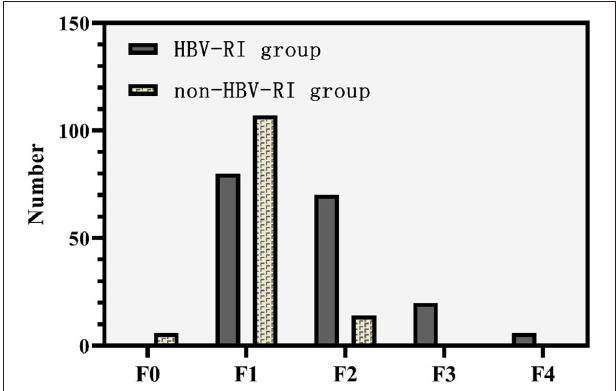
FIGURE 5 | Fibrosis stage F between the HBV-RI group and the non-HBV-RI group. HBV-RI group, HBV-related inflammation group; non-HBV-RI group, non-HBV-related inflammation group; HBV-related inflammation group: F0: 0 cases, F1: 80 cases, F2: 70 cases, F3: 20 cases, F4: 4 cases; non-HBV-related inflammation group: F0: 6 cases, F1: 107 cases, F2: 14 cases, F3: 0 cases, F4: 0 cases.